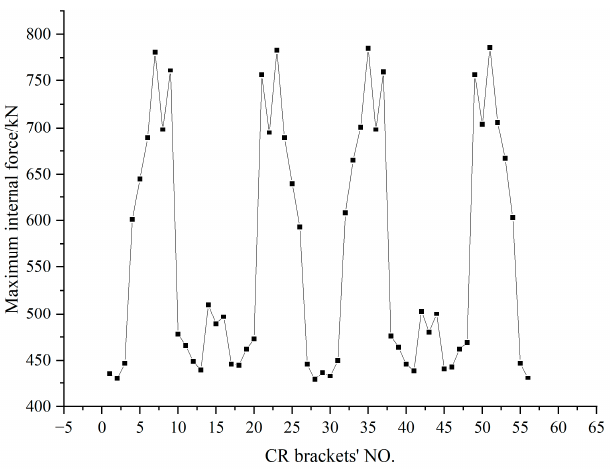
Figure 54. Variation curve of maximum internal force of each CR bracket (kN).